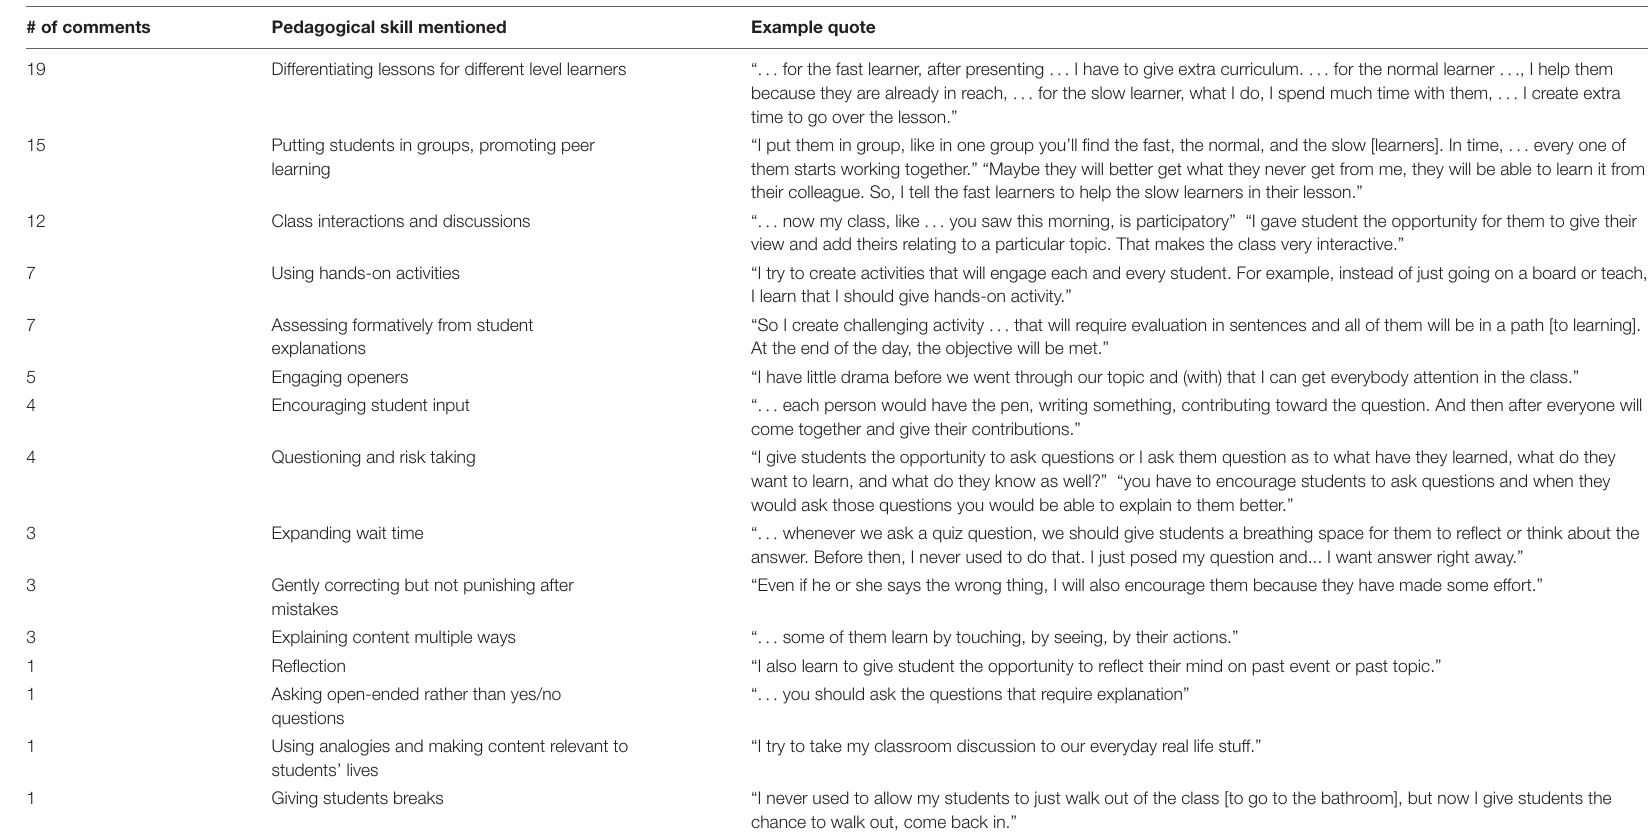
TABLE 4 | Pedagogical skills acquired during the